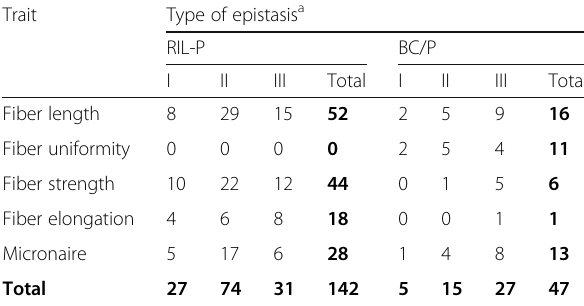
Table 5 Types of epistasis detected for fiber quality traits in the RIL-P and BC/P populations Trait